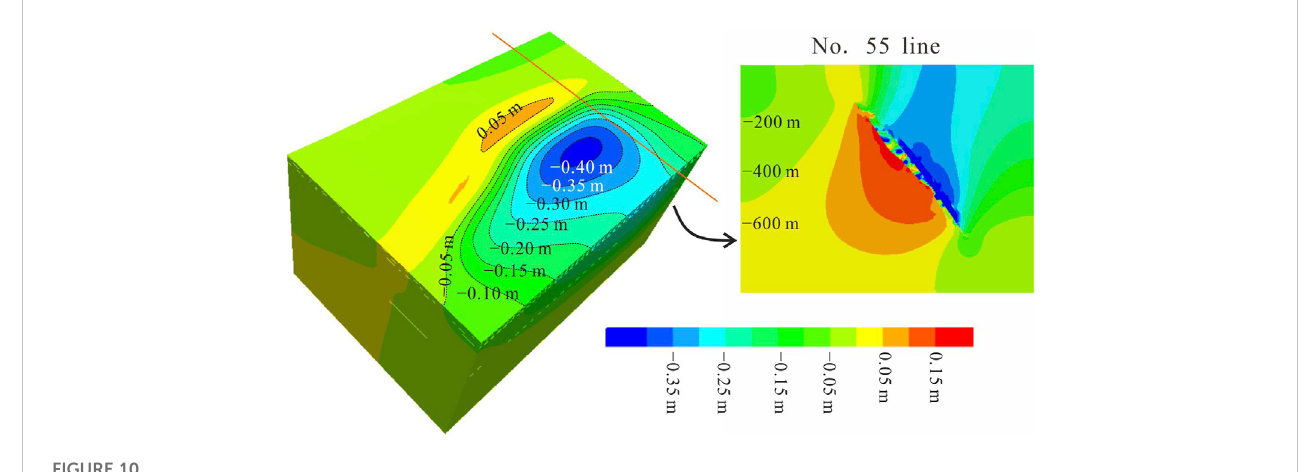
FIGURE 10 Vertical displacement result of the study area.